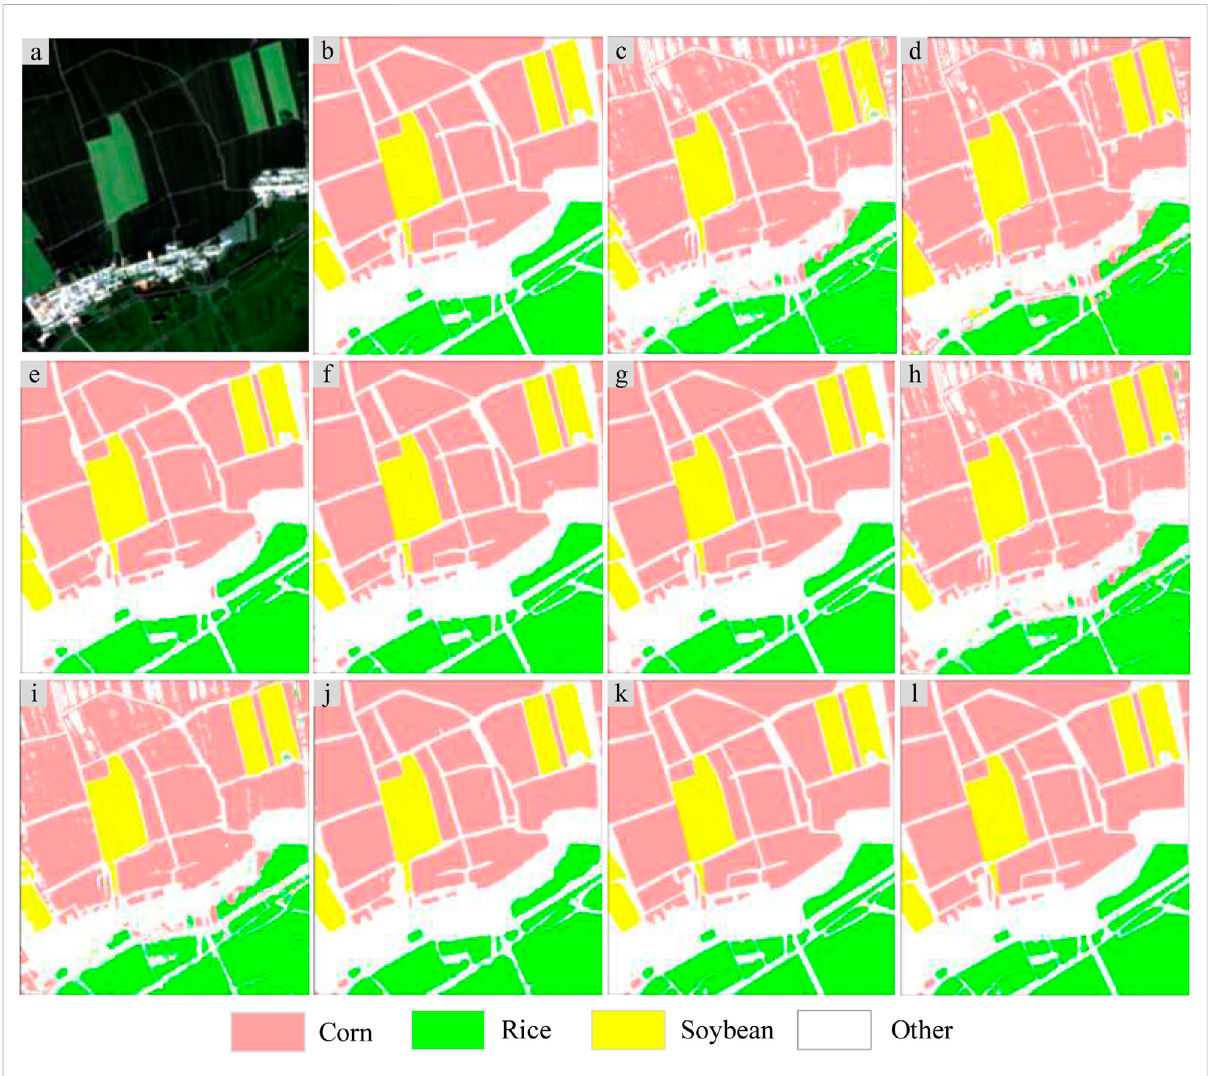
FIGURE 13 Comparison between machine learning algorithm and deep learning algorithm for image classi fi cation. (A) The original data. (B) Ground truth. (C – G) Results of RF, SVM, ResNet50, ResNetB, ResNetC based on RGB dataset, (H – L) Results of RF, SVM, ResNet50, ResNetB, ResNetC based on RGB + NDVI